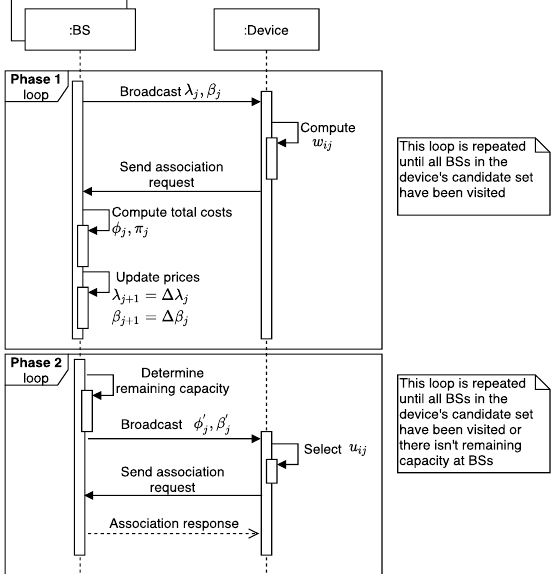
Figure 2. Sequence diagram of the BS assignment process performed based on the information exchange between each mobile device and its candidate